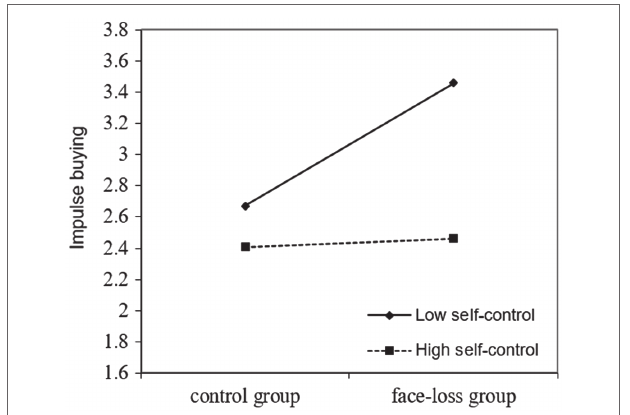
FIGURE 1 | Impulse buying as a function of face loss (face loss group vs. control group) and self-control (low vs.